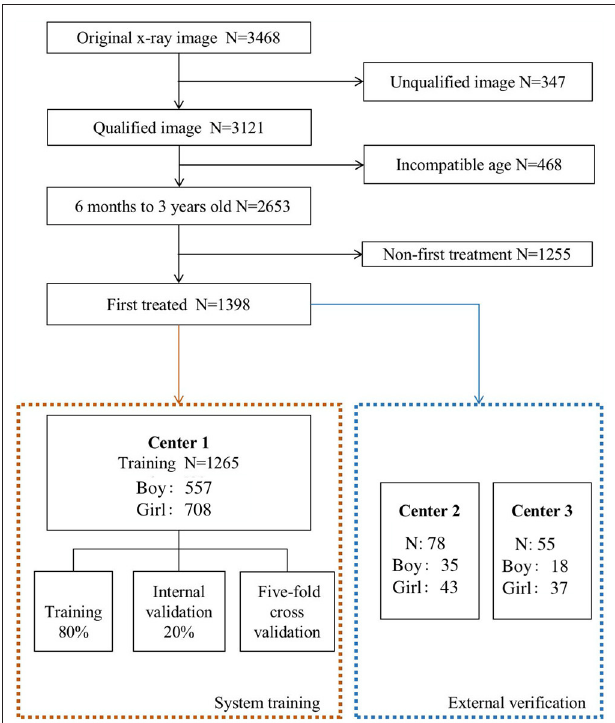
FIGURE 2 | The process of including and excluding x-ray images. The 1,398 x-ray images [Center 1 (1,265), center 2 (78) and center 3 (55)] were selected from 3,468 original x-ray images as the research